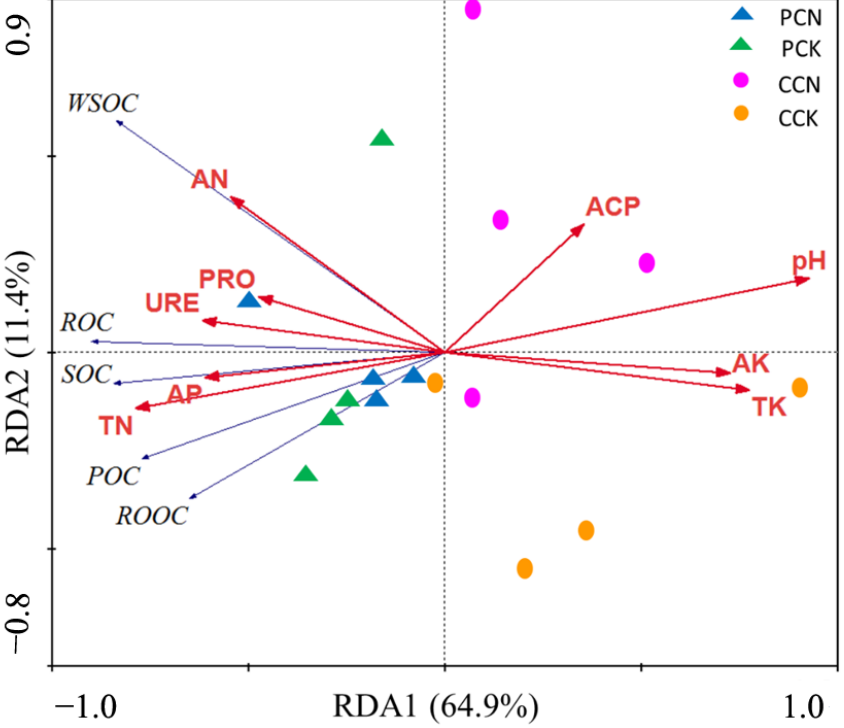
Figure 3. Redundancy analysis (RDA) of soil chemical properties and enzyme activities on soil or- ganic carbon and its organic carbon fractions. Organic carbon fractions (SOC: Total organic carbon;